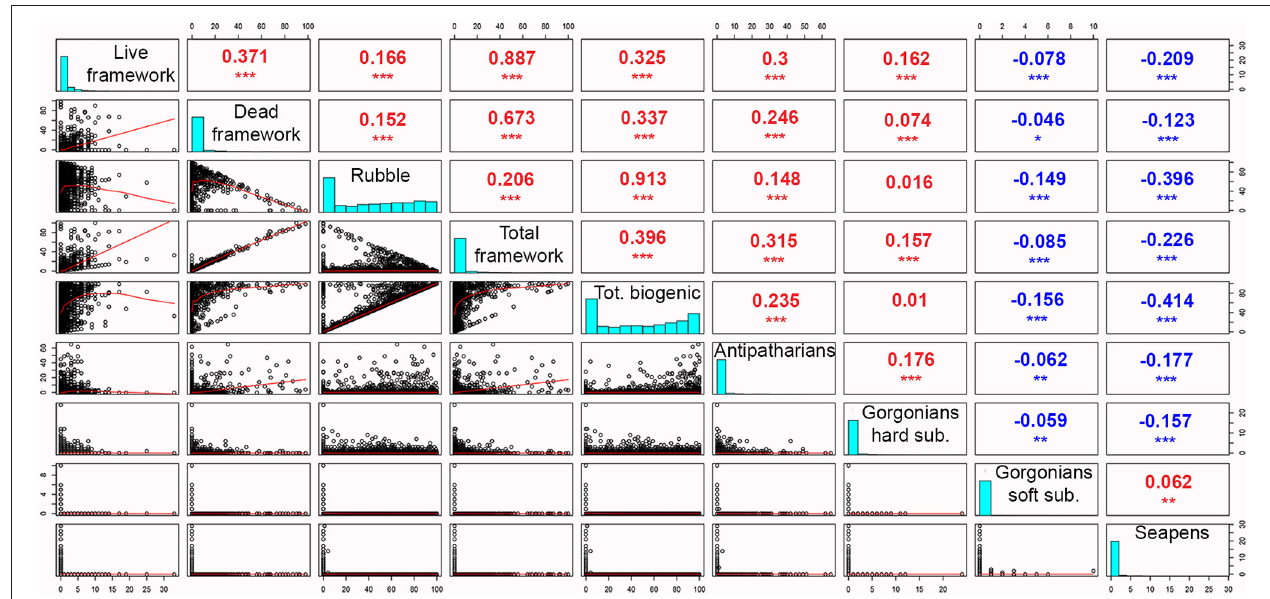
FIGURE 5 | Correlation matrix between scleractinian coral cover and the abundances of antipatharians, gorgonians on hard substrate, gorgonians on soft substrate and seapens. Lower matrix: correlation plots, upper matrix: Spearman coefficient and significance of the test ( p -value: * ≤ 0.05; ** ≤ 0.01, *** ≤ 0.001), diagonal data: distribution for each variable.